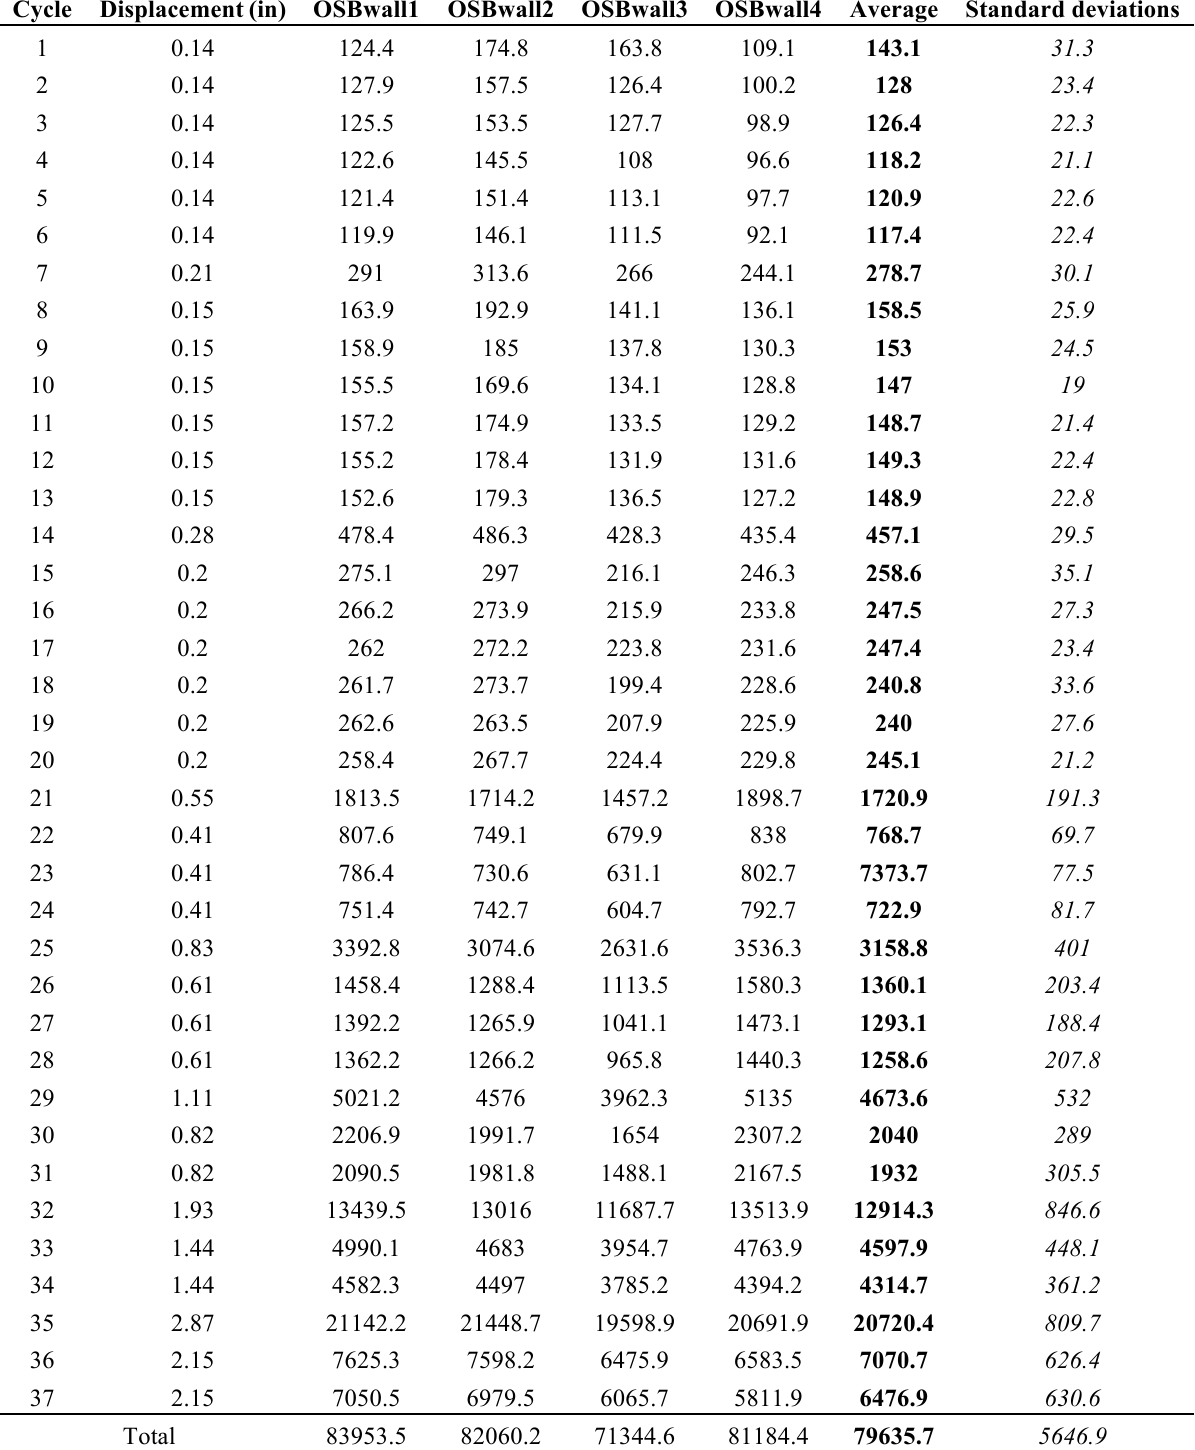
Table 1. Energy Dissipation (lb-in) of